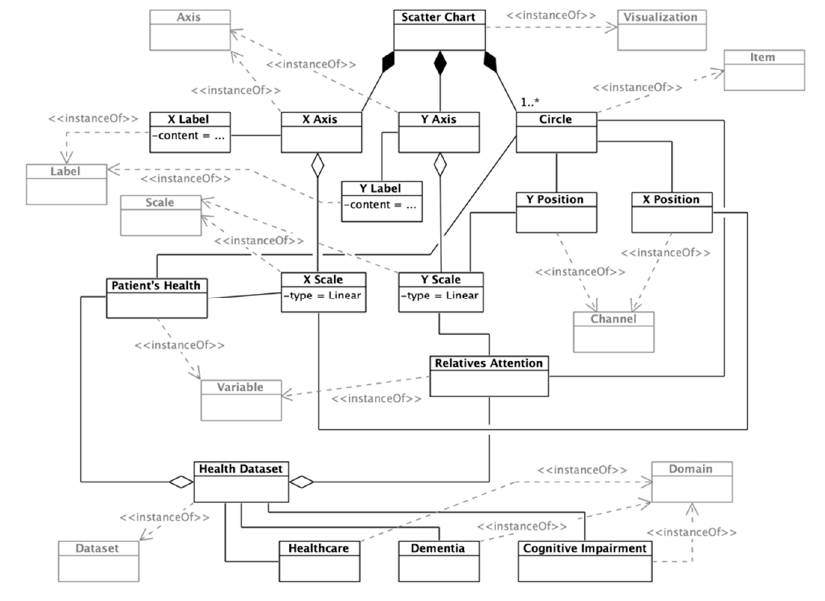
Figure 6. Dashboard meta-model instantiation regarding the scatter chart